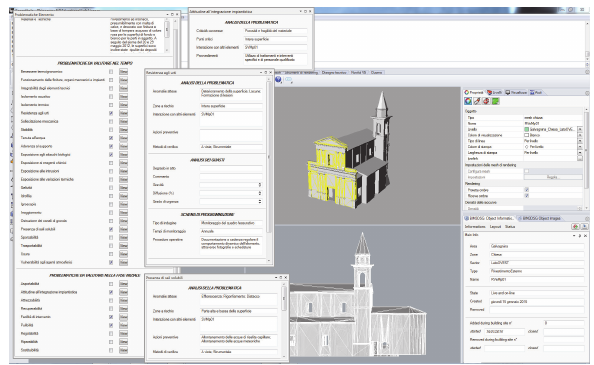
Figure 4. BIM3DSG dynamic information at work inside the modelling management